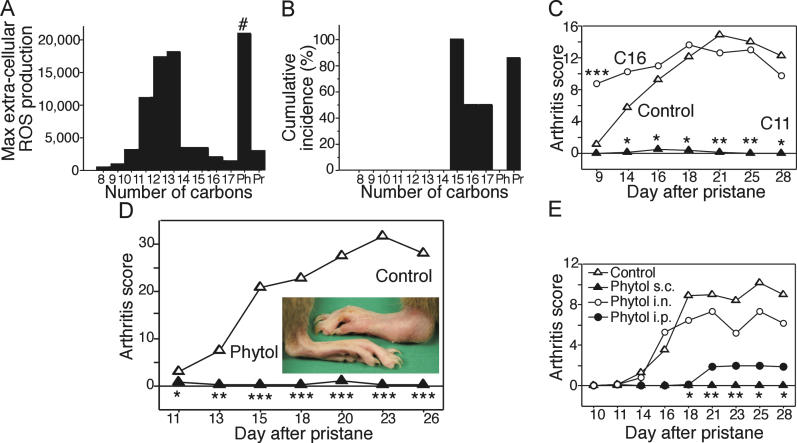
Substances Inducing Oxidative Burst In Vitro Prevent Arthritis(A) Structure of the oil is important for oxidative burst-inducing effect in vitro. Extracellular ROS production was measured with an isoluminol assay on HL-60 cells after in vitro stimulation with alkanes, phytol (Ph), or pristane (Pr). Data represent one of several experiments. #Value is divided by 10.(B) Alkanes longer than C15 induce arthritis. Arthritogenicity of alkanes (n = 4), phytol (Ph; n = 5), and pristane (Pr; n = 7) after SC administration in DA.Ncf1
DA rats. Results are presented as cumulative incidence in percent.(C) Oxidative burst-inducing alkanes prevent arthritis. Arthritis-preventing effect of selected alkanes after SC administration day −5 before PIA induction (control, n = 17; C11, n = 6; and C16, n = 5) in DA.Ncf1
DA rats.(D) Phytol inhibits development of arthritis. Preventive effect of phytol on PIA in DA.Ncf1
DA rats. Phytol was injected SC day −5 prior to pristane injection (control, n = 12; phytol, n = 13).(E) The preventive effect of phytol is dependent on route of administration. Preventive effect of phytol on PIA in DA.Ncf1
DA rats after IP (200 μl), SC (200 μl), or intranasal (25 μl) administration on days −5 and +5 (n = 7).*p < 0.05, **p < 0.01, ***p < 0.001.